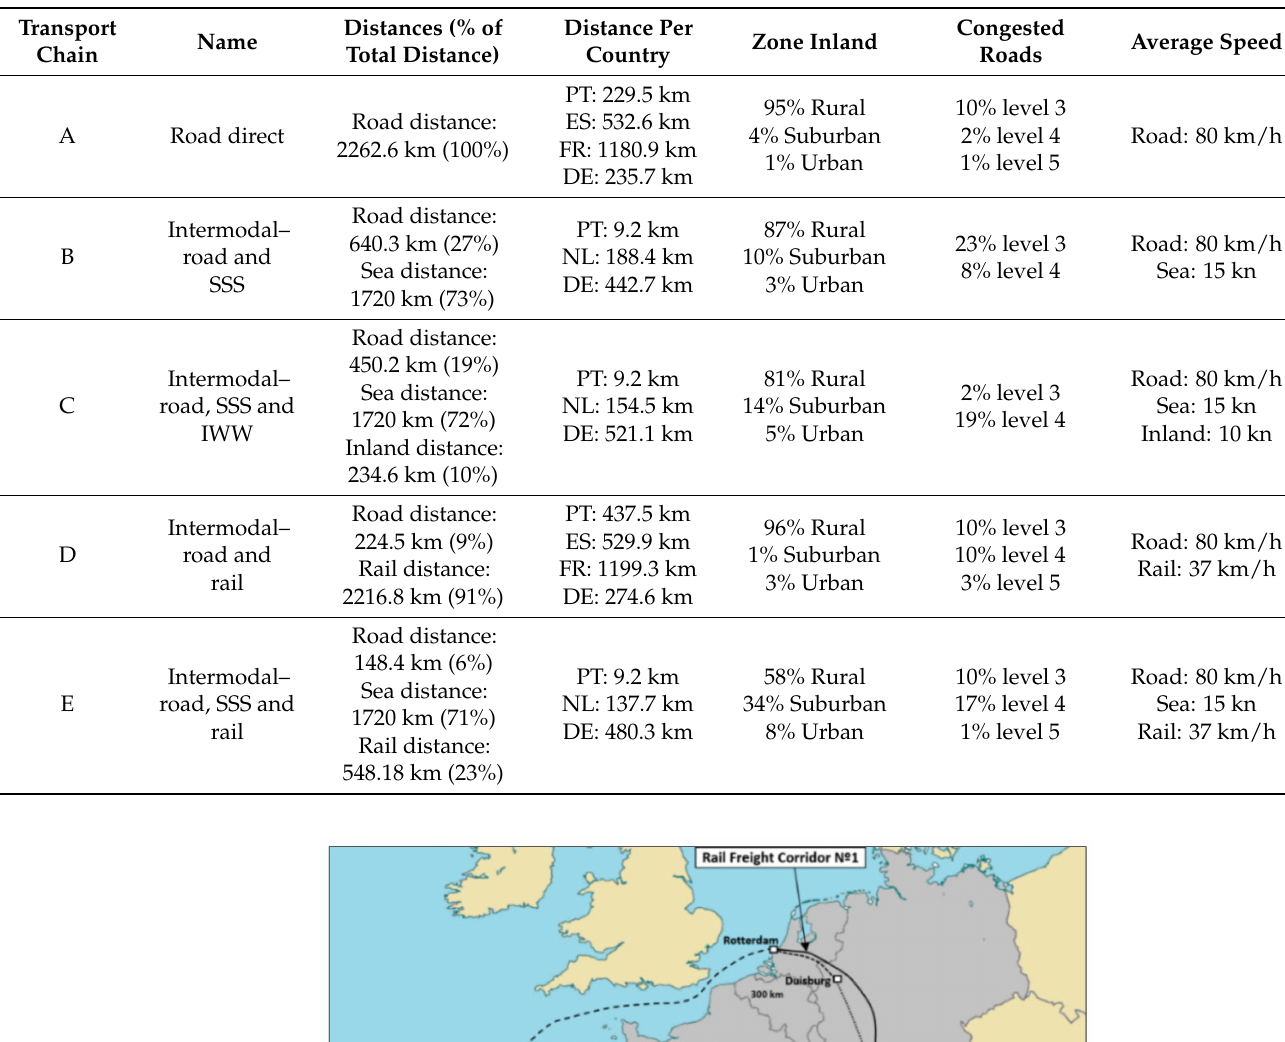
Table 3. General characteristics of the different transport chains (A: unimodal; B–E: intermodal) between Porto and Stuttgart. Transport